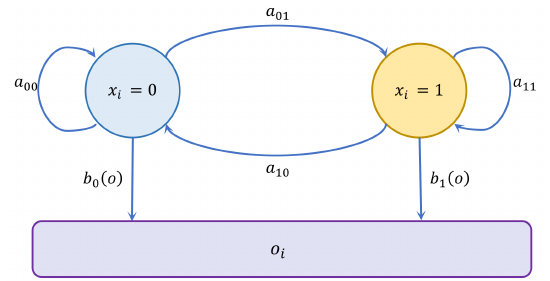
Figure 4. Continuous hidden Markov